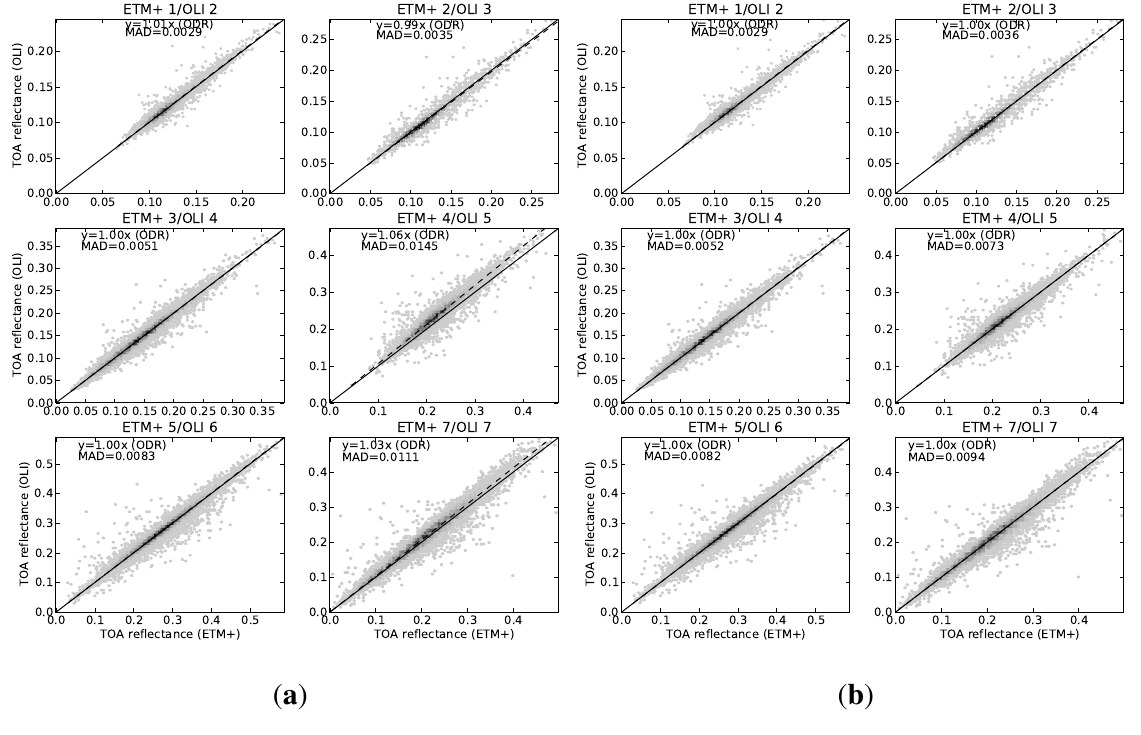
Figure 3. Top-of-atmosphere reflectance for Landsat-7 and Landsat-8. ( a ) Reflectance for corresponding bands, without adjustment; ( b ) Reflectance for corresponding bands, with OLI values adjusted using fitted regression to match ETM+ values. Solid line is the one-to-one line, dashed line is the orthogonal distance regression